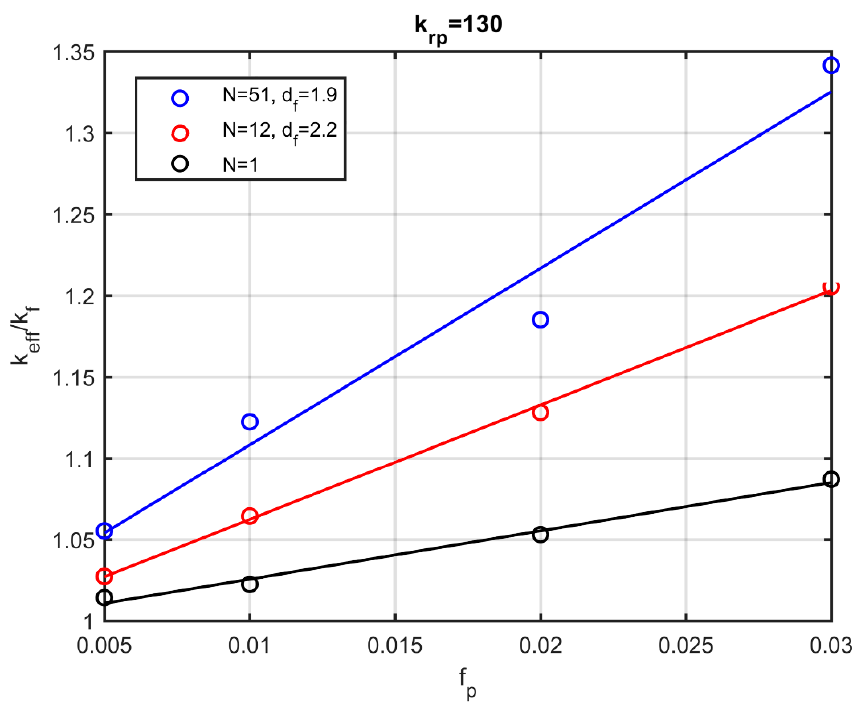
Figure 11. Effective thermal conductivity as a function of the volume fraction of the particles.